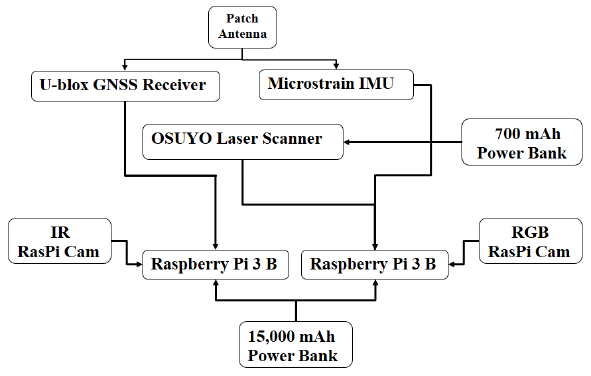
Figure 5. Basic architecture of bike mobile system